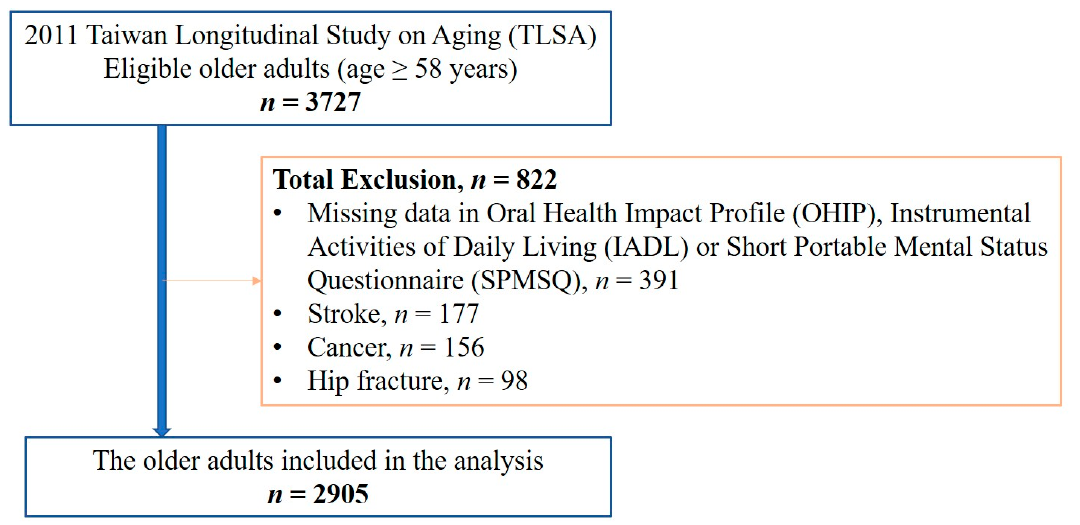
Figure 1. Flow diagram of patient inclusion process.